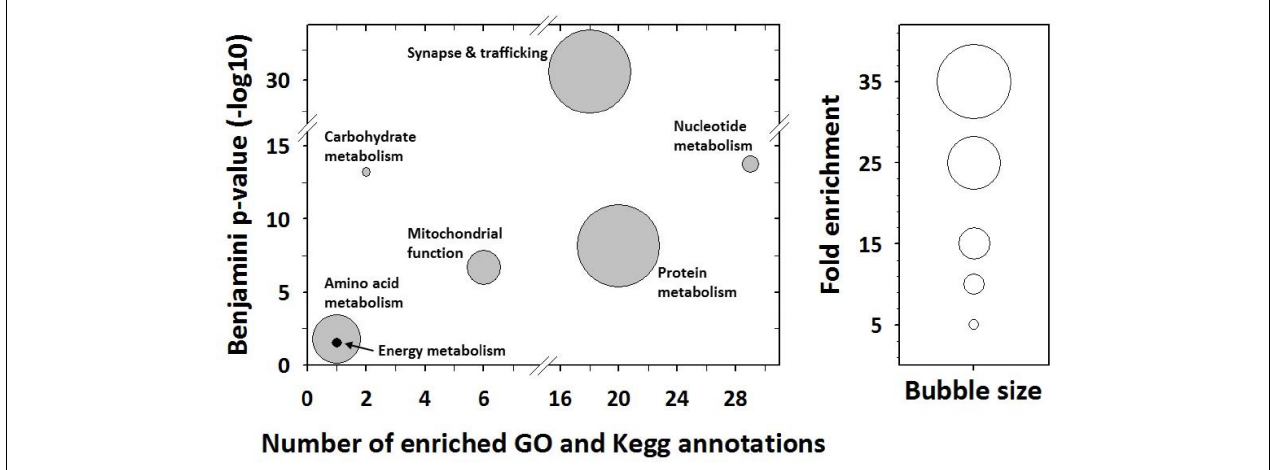
FIGURE 2 | Functional annotation enrichment analysis from differentially expressed proteins. The analysis was performed using the desktop version of DAVID (Ease v2.1) from protein gene ontology and Kegg pathway annotations. Significantly enriched GO terms and Kegg pathway maps were determined using the